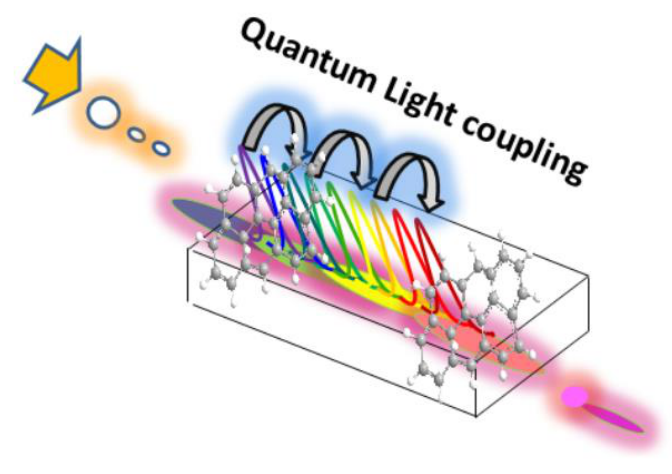
Figure 10. Scheme of modified substrate with optical active nanomaterials including quantum graphene dots within a metamaterial substrate for coupling and waveguiding. Reprinted with permission from ref. [88]. Copyright 2022, Current Material Science (CMS)-Recent Patents on Materials